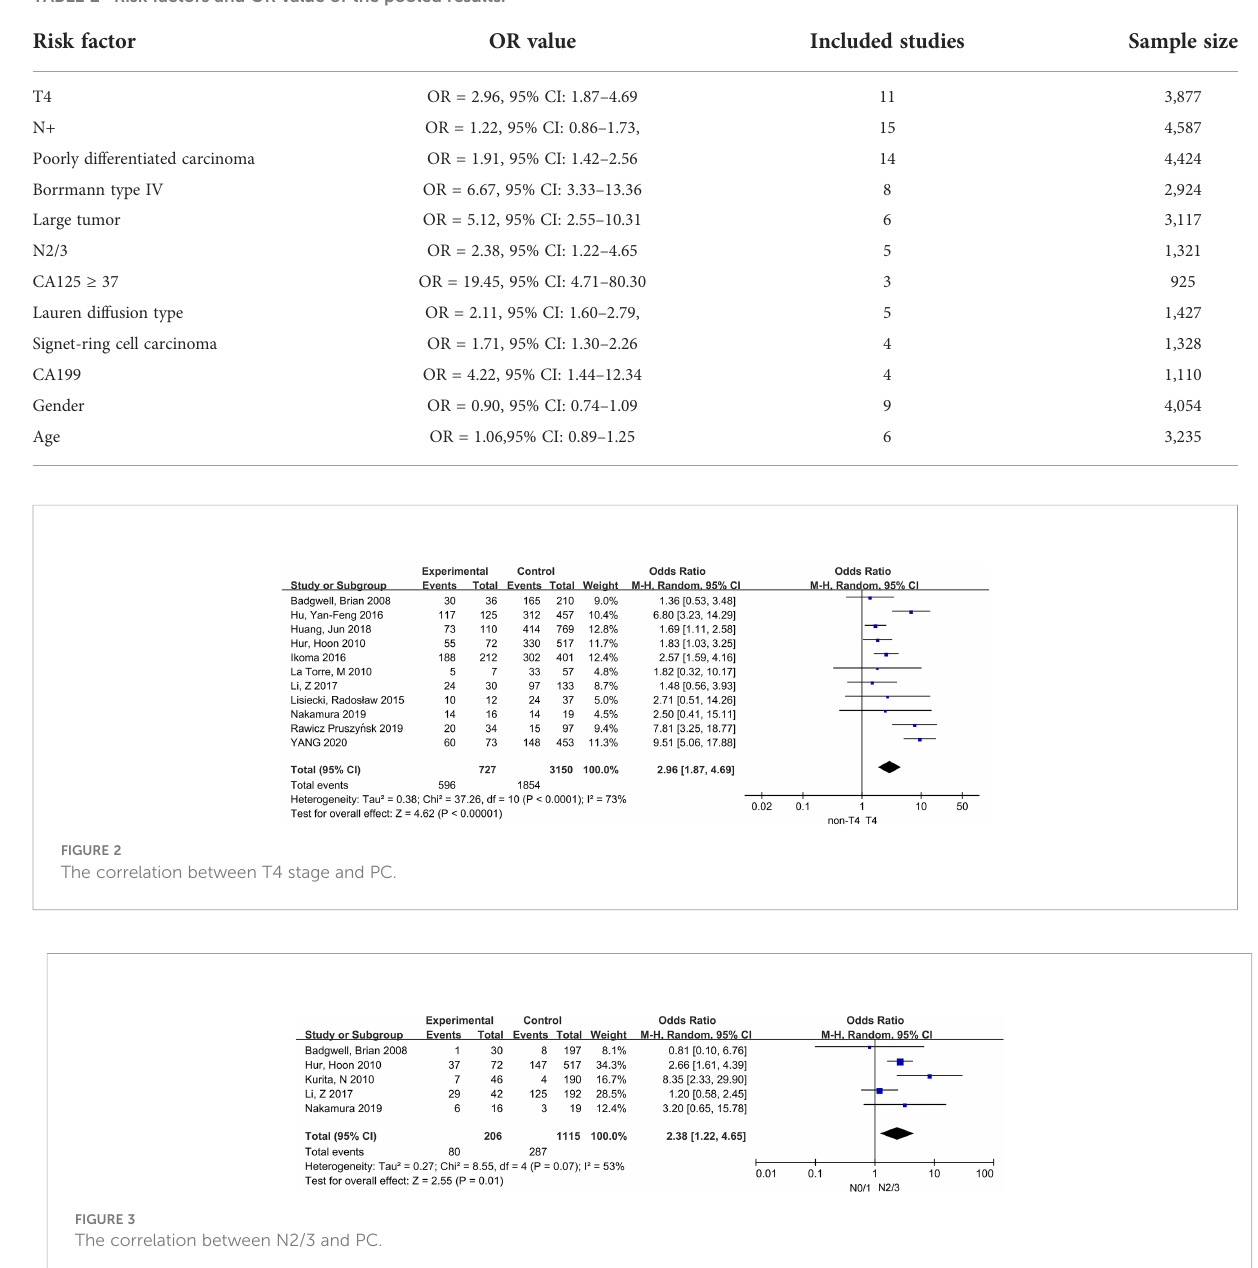
TABLE 2 Risk factors and OR value of the pooled results.